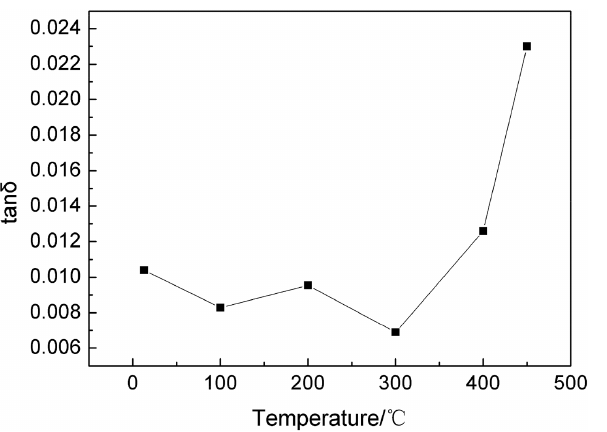
Figure 7: Variation of the loss tangent of the CuCl residue with temperature.